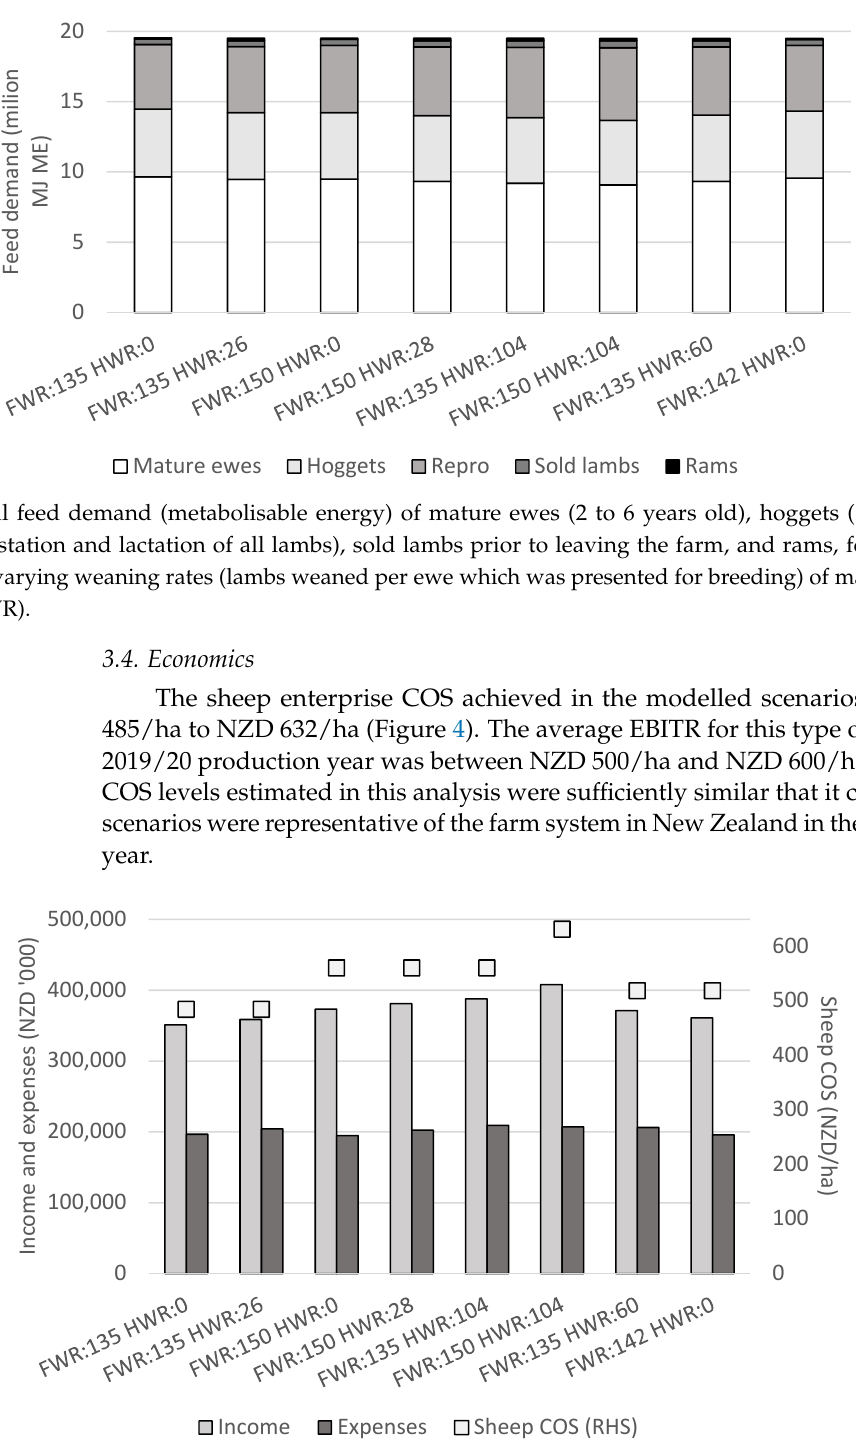
Figure 4. Income from sales of sheep and wool, expenses, and cash operating surplus (COS), for scenarios with combinations of varying weaning rates (lambs weaned per ewe which was presented for breeding) of mature ewes (FWR) and hoggets (HWR). RHS = right hand side axis.